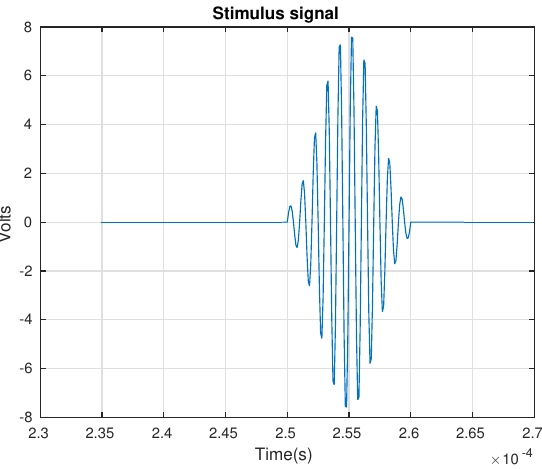
Figure 3. Excitation signal applied to the piezoelectric acting as the actuator, in each actuation